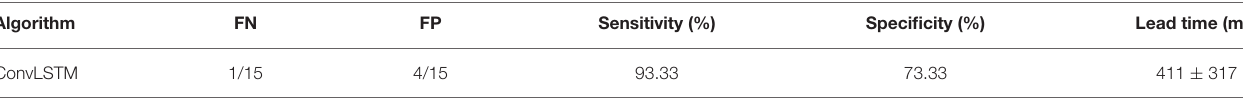
TABLE 4 | Validation performance of ConvLSTM on the FARSEEING real-world fall dataset. Algorithm FN